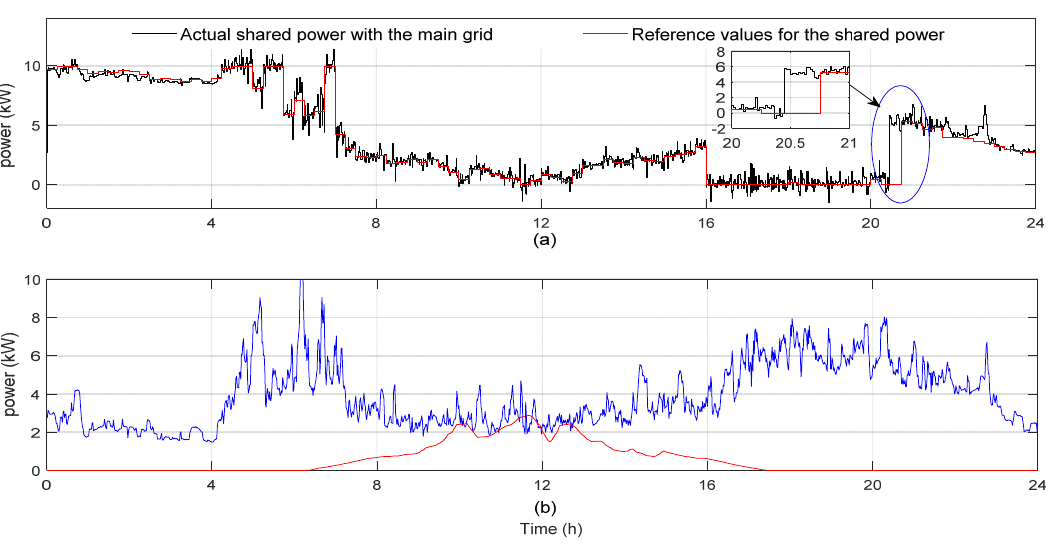
Figure 14. ( a ) Actual and the reference values for the power drawn by the MG from the main electricity grid; ( b ) Electrical load and PV generation profiles (1 min sample time).